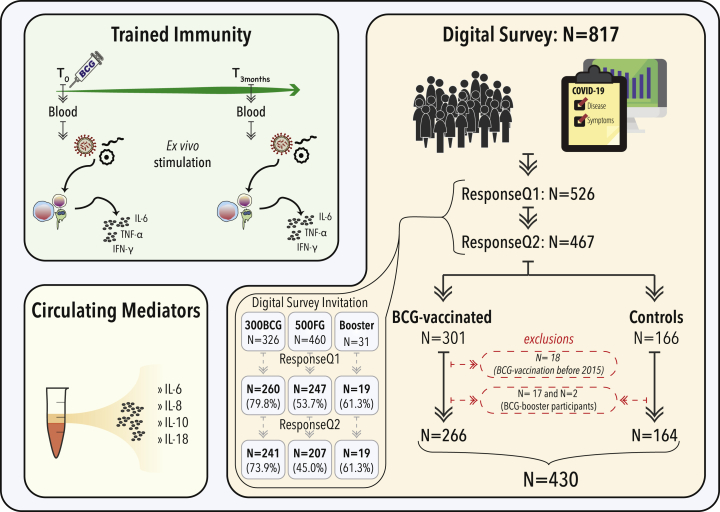
Schematic Overview of the StudyThe dataset consists of 430 adult volunteers of which 266 volunteers received the BCG vaccine in the last 5 years and 164 individuals did not receive the BCG vaccine (control group). Information about disease and any symptoms between February 27th to April 30th 2020, as well as other metadata including recent travel history and previous contact with SARS-CoV-2 infected individuals were collected via two digital surveys that were sent to participants of the 300BCG, 500FG, and BCG-booster cohorts. Participants that received a BCG vaccination before 2015 and participants from the BCG booster cohort that received a BCG vaccine between February 27th and April 30th were excluded from analysis. Circulating immune parameters were assessed in individuals from the 300BCG and 500FG cohorts. The BCG-induced trained immunity response was assessed in the 300BCG cohort by comparing cytokine levels upon ex vivo stimulation of peripheral blood mononuclear cells (PBMCs) 3 months after BCG vaccination to the levels before vaccination. Annotation: ResponseQ1 = response survey 1, containing information on disease and symptoms between February 27th to March 31st 2020; ResponseQ2 = response survey 2, containing information on disease and symptoms between April 1st to April 30th 2020. For information on timing of BCG vaccination see Figure S1.